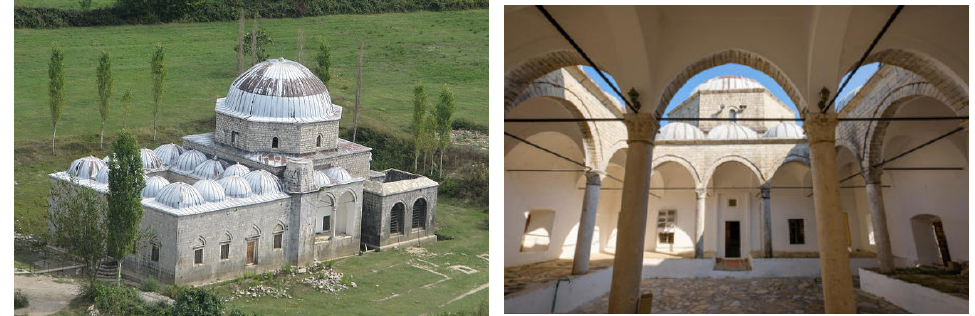
Figure 12. Perspectival views of the Lead Mosque in Shkodra [13].